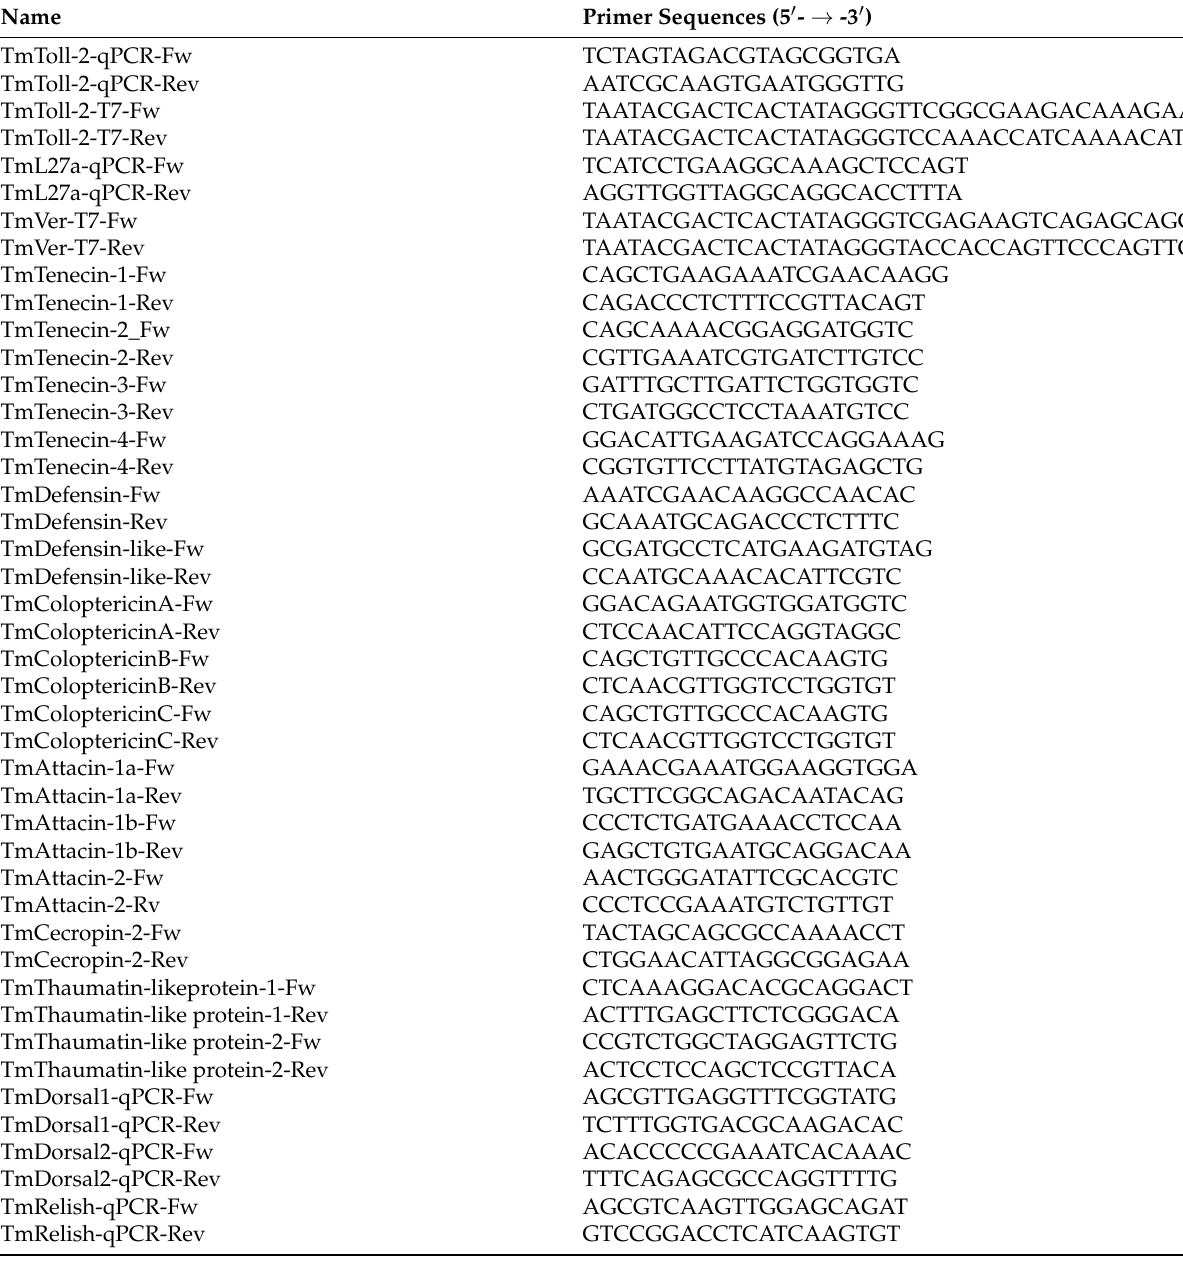
Table 1. Primers used in the present